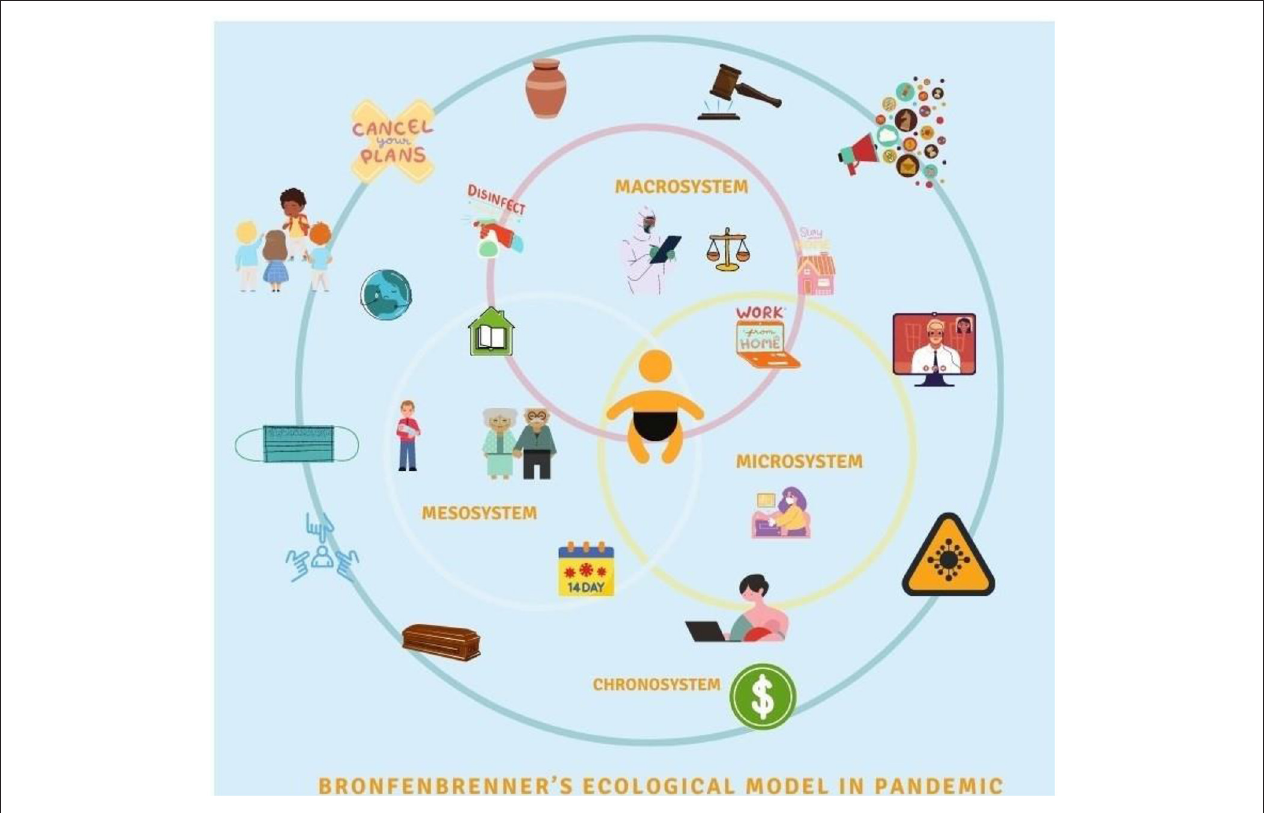
FIGURE 2 | Bronfenbrenner’s bio-ecological model; systems and their interactions with childhood development during COVID-19 pandemic.